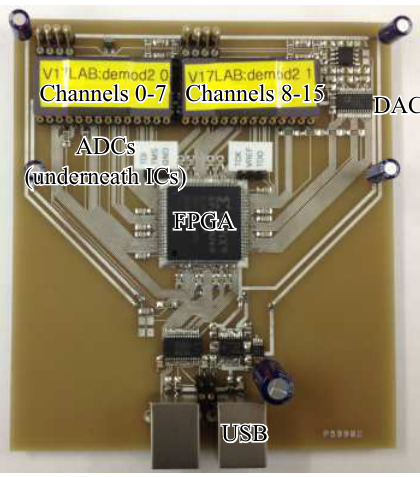
Figure 9. Picture of the sampling system